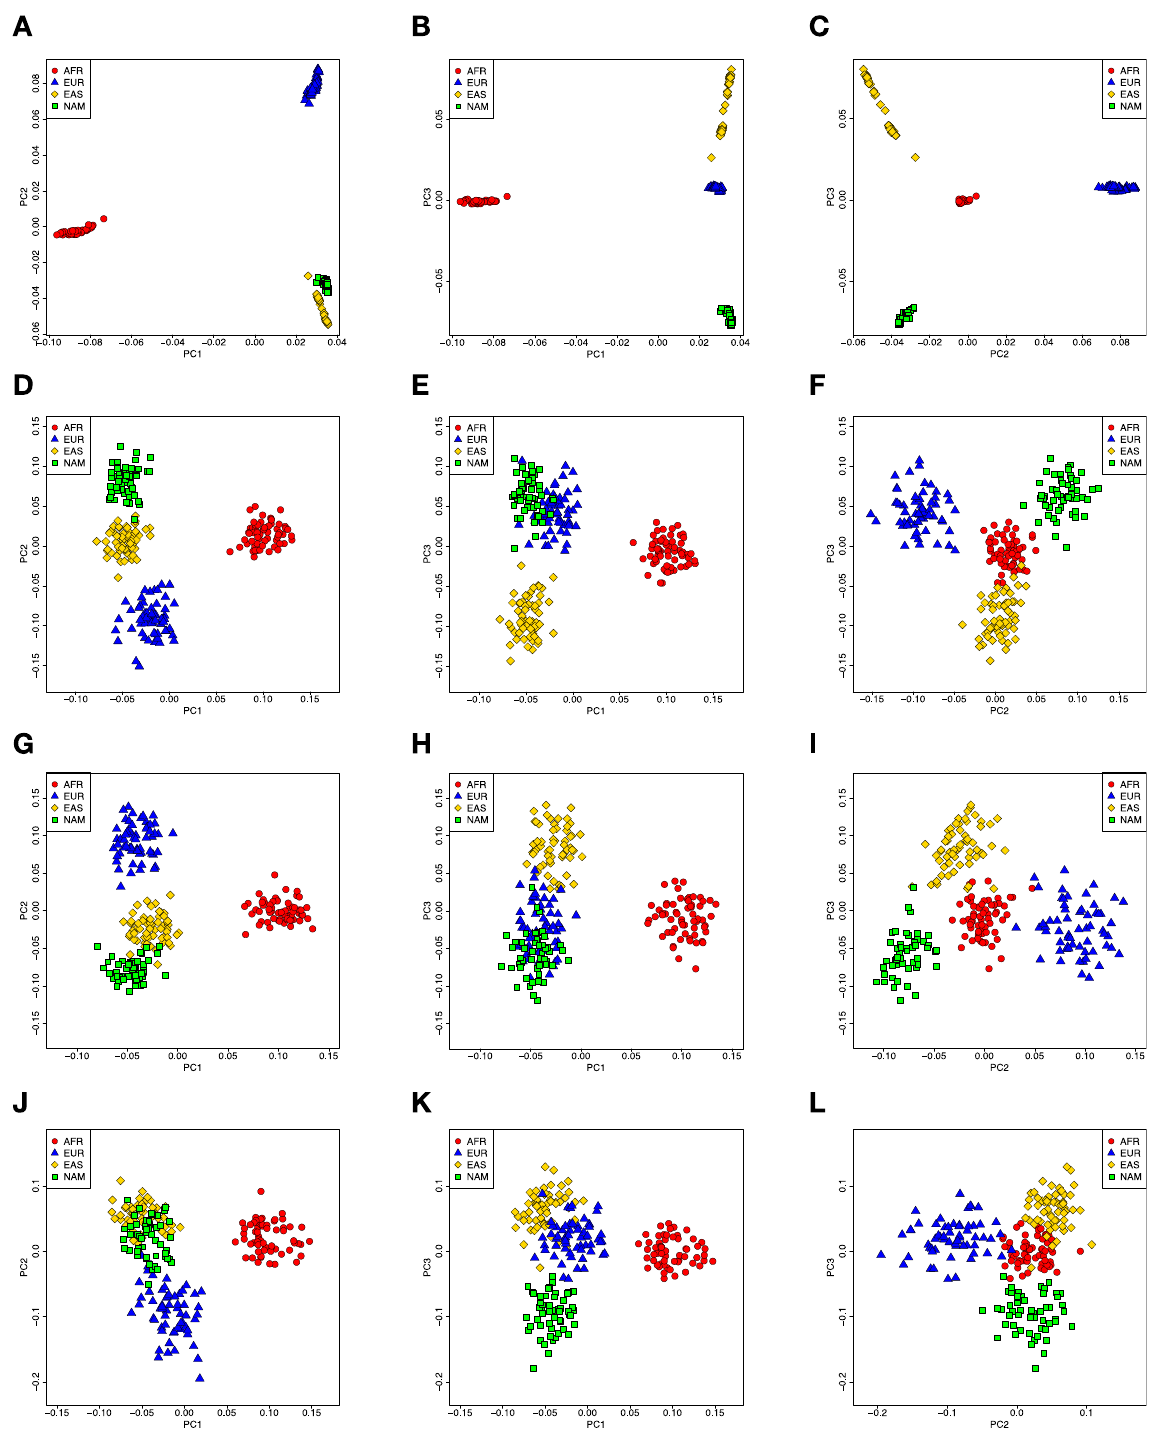
Figure 1. Principal Component Analysis of four major ancestry populations represented by AFR, EUR, EAS and AMR used as reference samples. ( A – C ) Genome-wide panel; ( D – F ) preemptive PGx panel; ( G – I ) DMET panel and ( J – L ) VIP